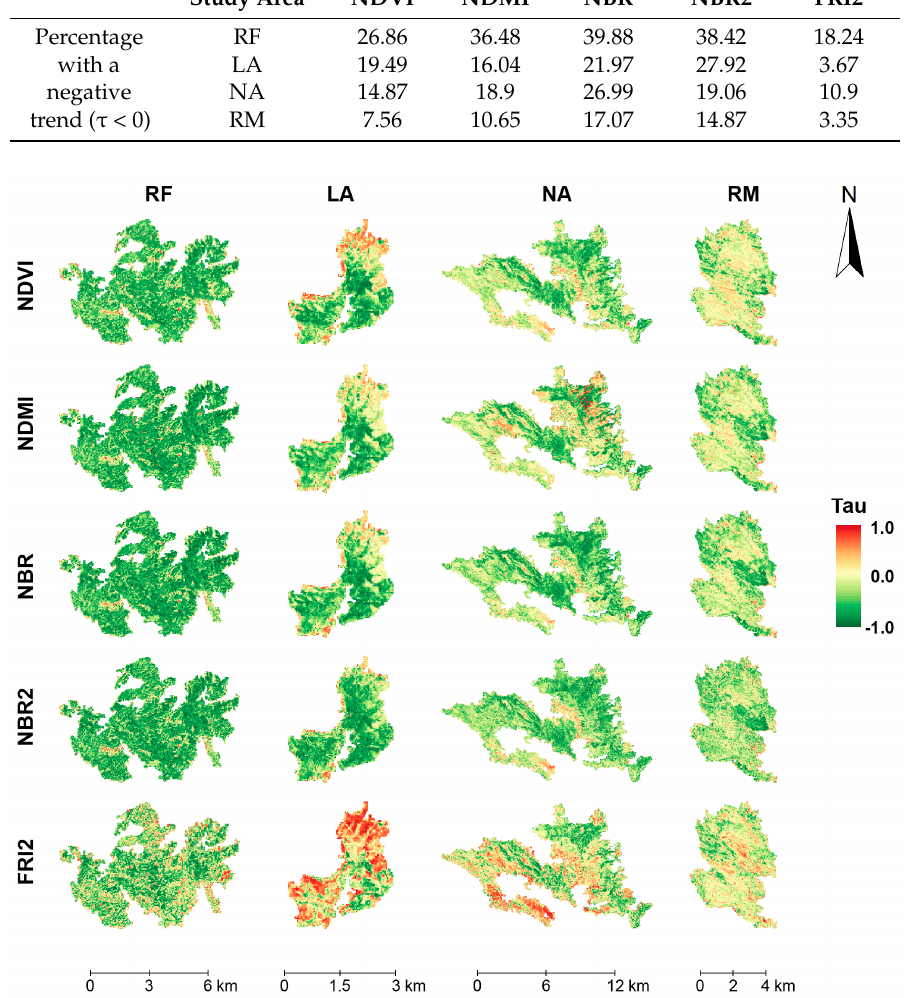
Table 4. Percentage of pixels with a significant negative trend ( p < 0.01) of RDSVIs with respect to the number of pixels within the area of interest of the study areas. Study areas are Roccafluvione (RF), L’Aquila (LA), Navelli (NA), and Roccamorice (RM).